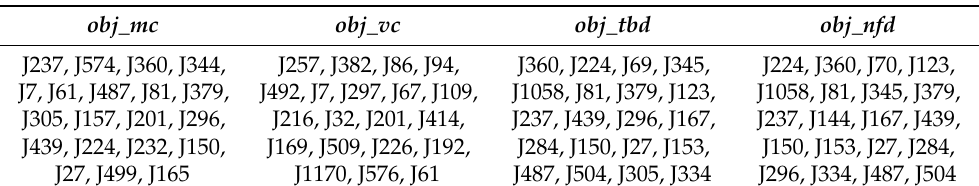
Table 4. Sensors generated from other objective functions, arranged by rank from most to least critical.